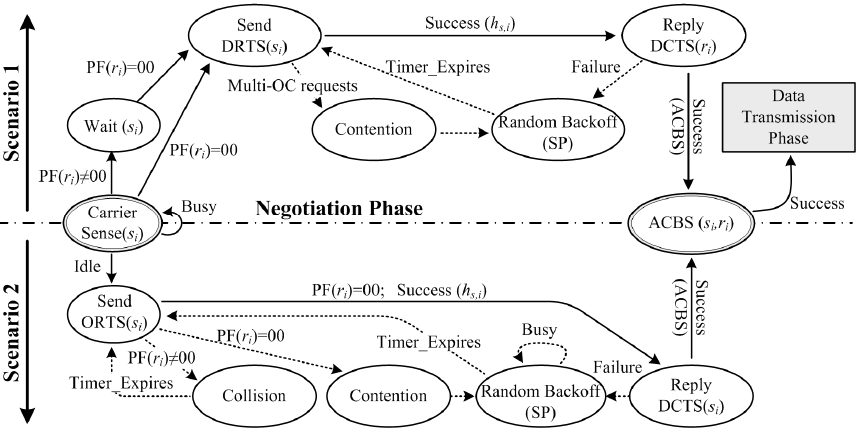
Figure 4. State diagram of Scenarios 1 and 2 in the negotiation phase.